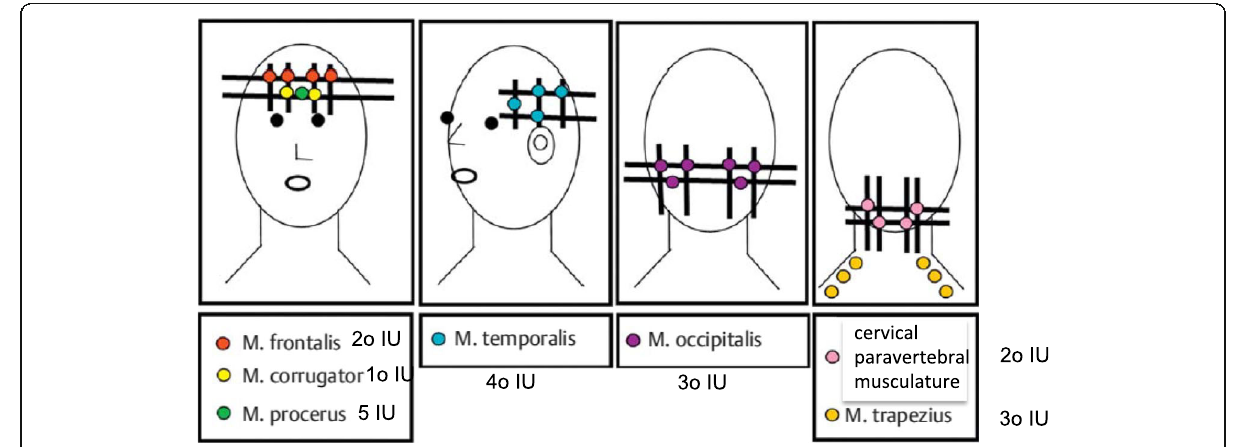
Fig. 1 Injection procedure of OnabotulinumtoxinA according to the PREEMPT study